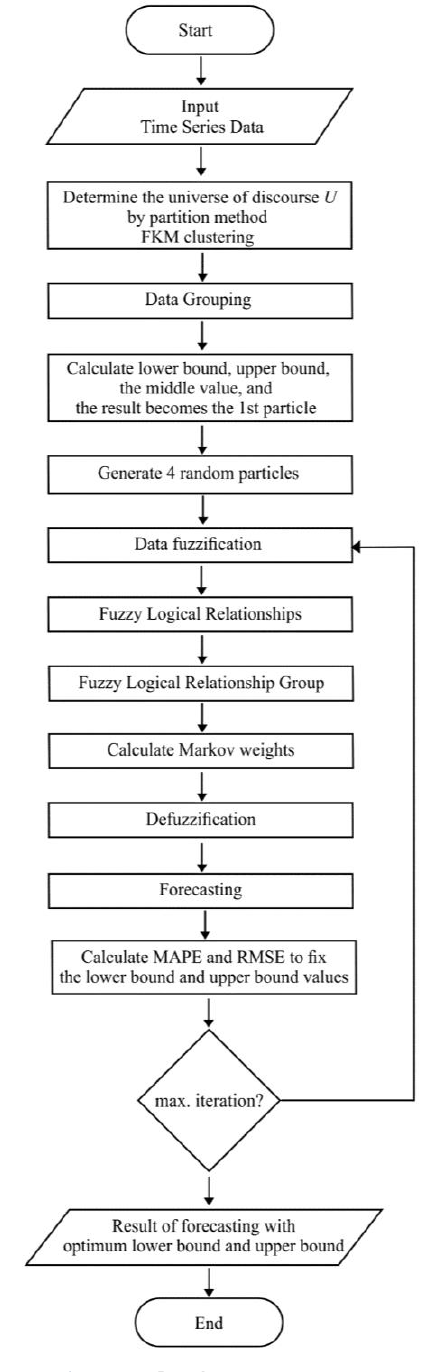
Figure 3. Flowchart